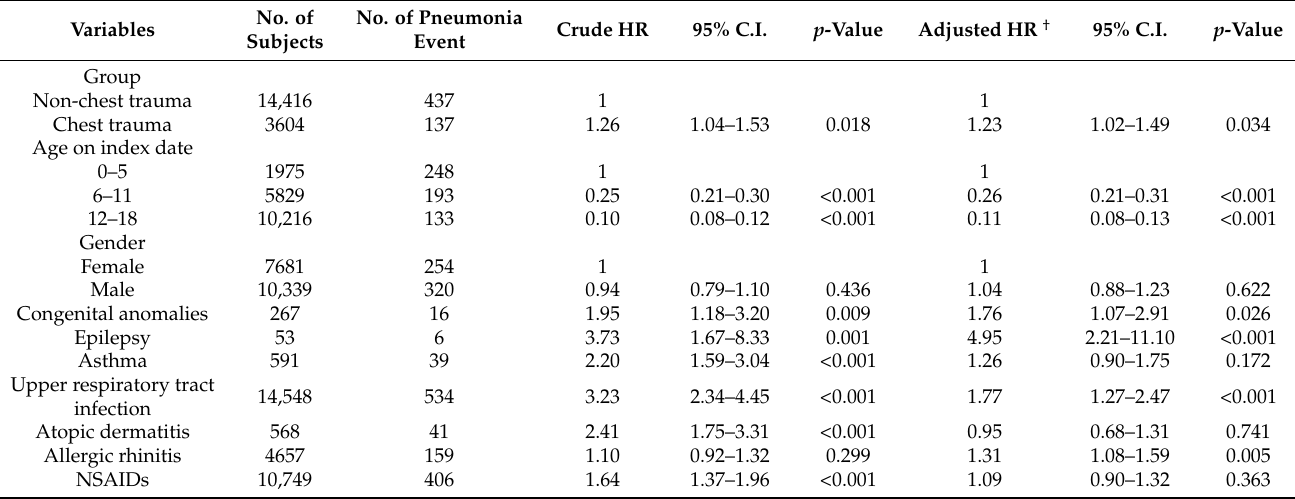
Figure 2. Kaplan–Meier curves of the cumulative proportion of pneumonia. Table 2. Cox proportional hazard model of pneumonia event.